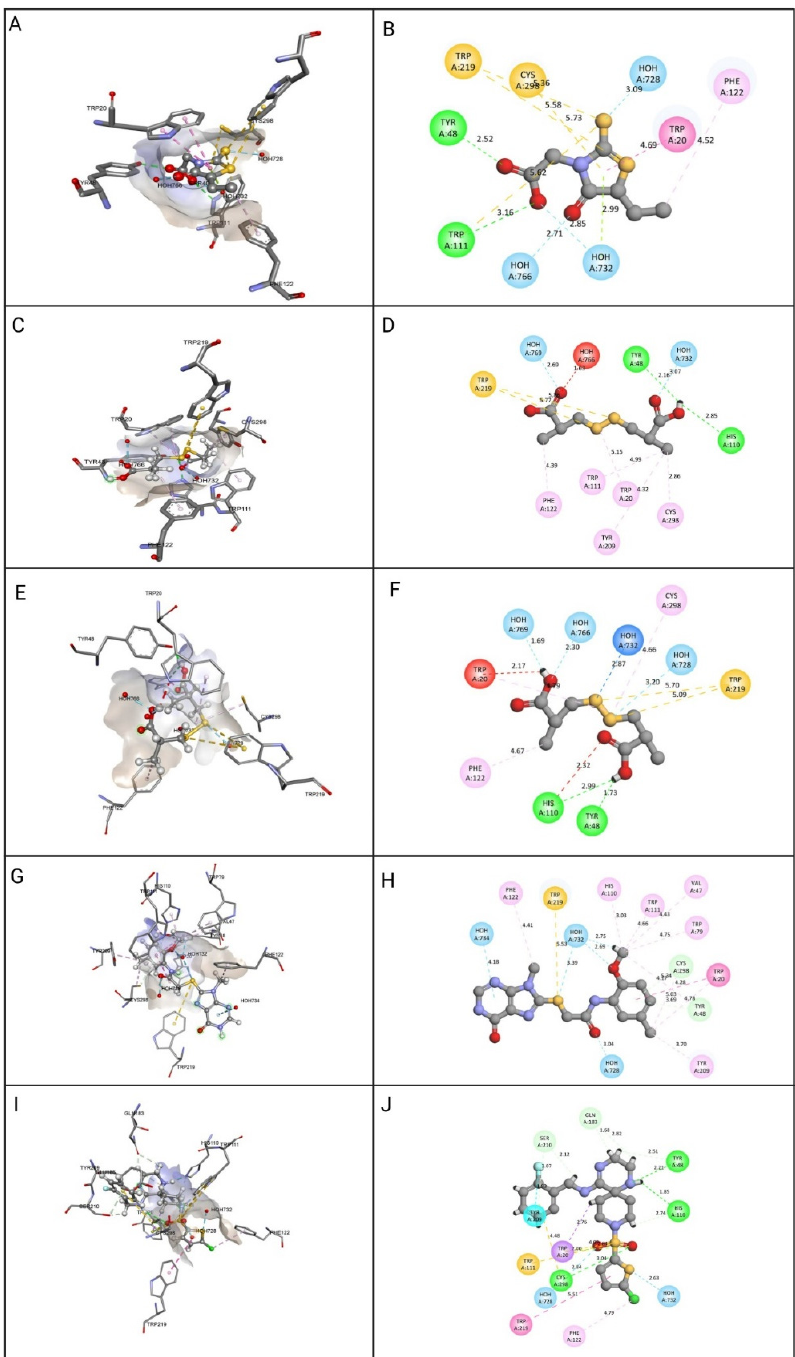
Figure 5. Molecular docking view of the compounds at the binding sites of ALR-2 (PDB ID: 4JIR). The stereo image of the docked complex containing the compound and receptor protein is presented on the left side, whereas the 2D view of the interactions between compounds and 4JIR is presented on the right side. Discovery Studio was used to construct the diagrams; hydrogen bonds are depicted in the green dashed line, hydrophobic interactions in the pink dashed line, and sulfur interactions in the yellow dashed line. The distance between them is displayed in angstroms. The amino acid residues in a protein structure were each given a three-letter code, and the compound is displayed in a ball-and-stick format. ( A ) epalrestat 3D view, ( B ) epalrestat 2D view, ( C ) ZINC000002895847 3D view, ( D ) ZINC000002895847 2D view, ( E ) ZINC000002566593 3D view, ( F ) ZINC000002566593 2D view, ( G ) ZINC000012447255 3D view, ( H ) ZINC000012447255 2D view, ( I ) ZINC000065074786 3D view, ( J ) ZINC000065074786 2D